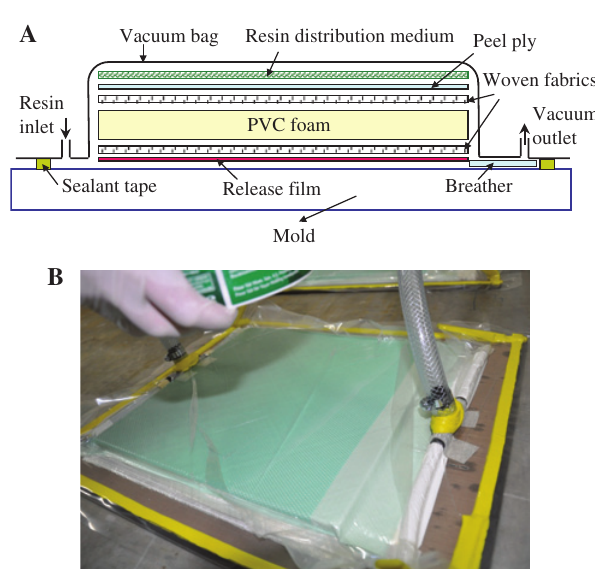
Figure 2 Manufacturing of samples by vacuum-assisted resin infusion process: (A) schematic view and (B) a photo from manufacturing.